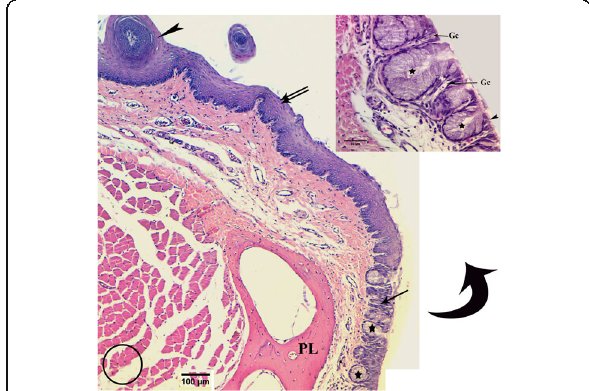
Fig. 12 Photomicrograph of a transverse section of hoopoe shows the epithelium roof is non-keratinized (double arrows), appears only to cover the papillae (head arrow), then changes gradually into pseudostratified ciliated columnar epithelium (arrow) with simple alveolar gland (star). Upper right shows goblet cells (Gc) within pseudostratified ciliated columnar epithelium (head arrow) and simple alveolar gland (star). (H&